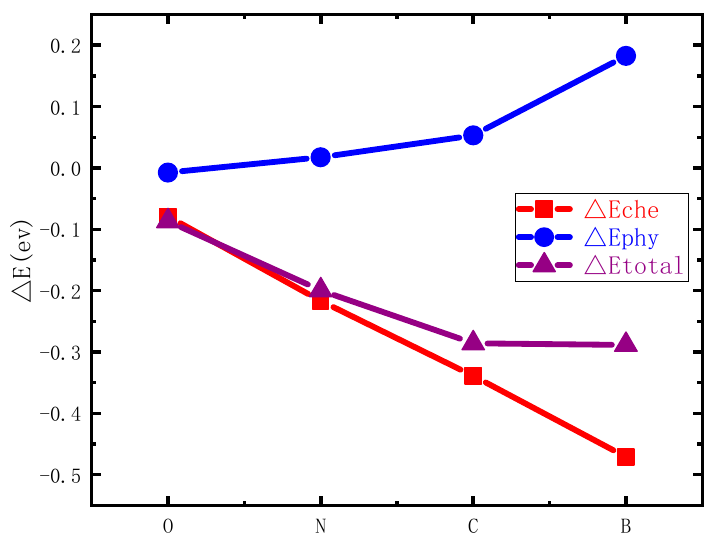
Figure 5. Contribution of interstitial atoms to the reduction of energy barrier in two systems.